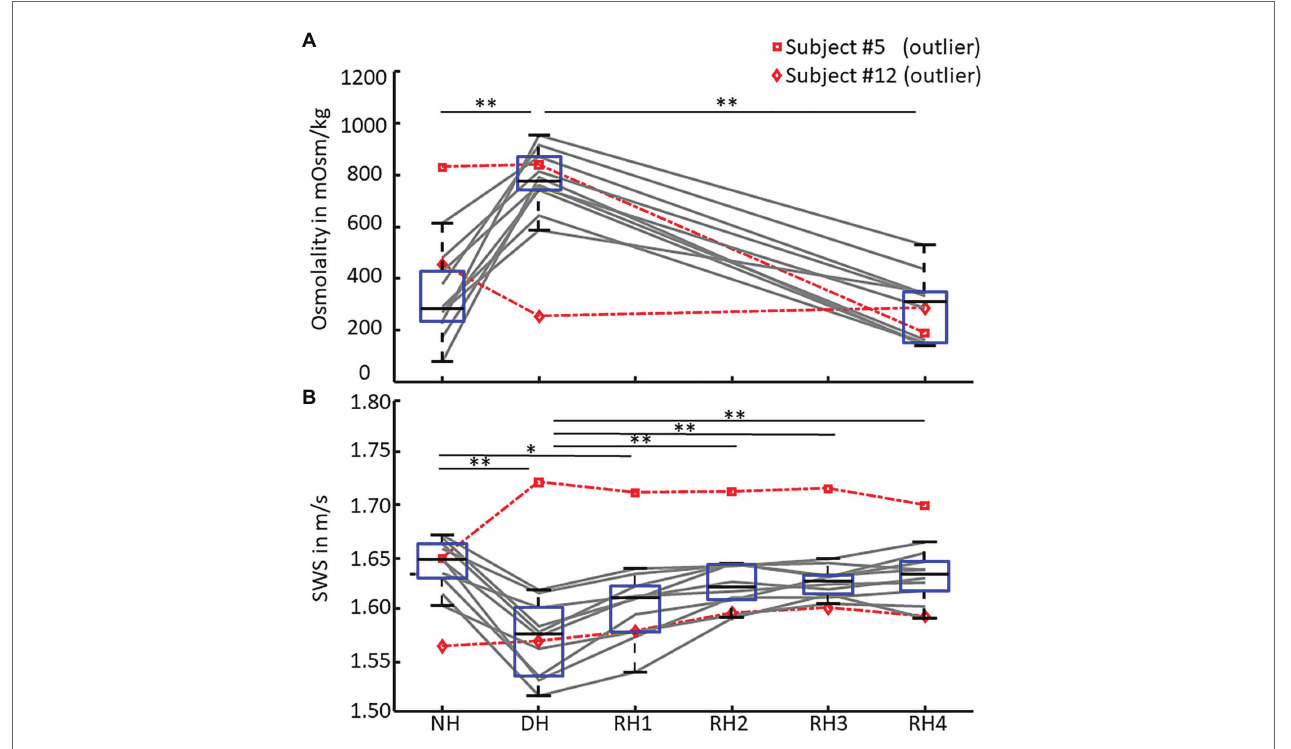
FIGURE 5 | SWS and urine osmolality changes during de‐ and rehydration. Boxplots of (A) urine osmolality for three hydration states – normal hydration (NH), dehydration (DH), and rehydration (RH4) and (B) mean shear wave speed (SWS) across all hydration states measured in each volunteer. Urine osmolality increased after dehydration and decreased to normal hydration values after 1 h of rehydration. Conversely, SWS significantly decreased after 12 h of fasting and returned to normal hydration values within 30 min of oral rehydration. Volunteers #5 ( □ , dashed red) and #12 (◊, dashed red) were excluded from statistical group analysis due to incomplete fasting, as reflected in urine osmolality and confirmed by them after the experiment. Significant differences between the groups are indicated by * p < 0.05 and ** p < 0.001.